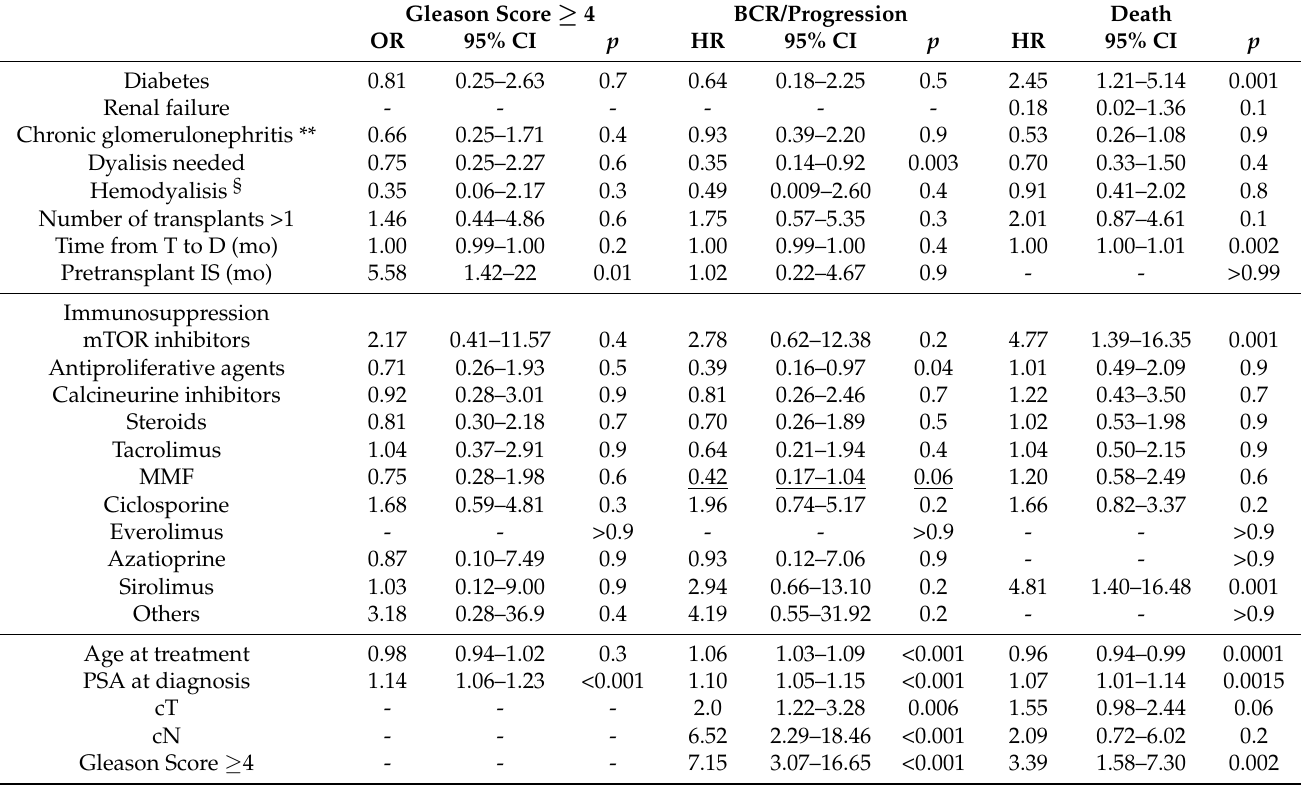
Table 4. Univariate